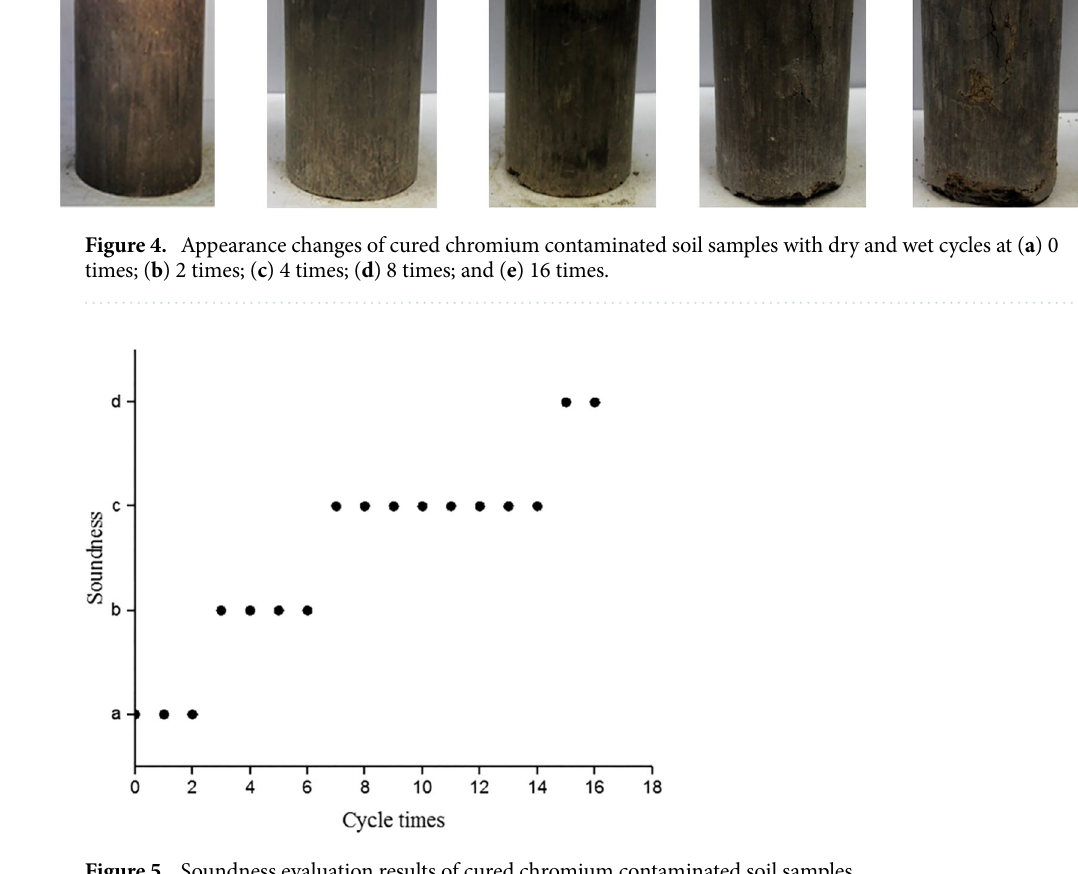
Figure 5. Soundness evaluation results of cured chromium contaminated soil